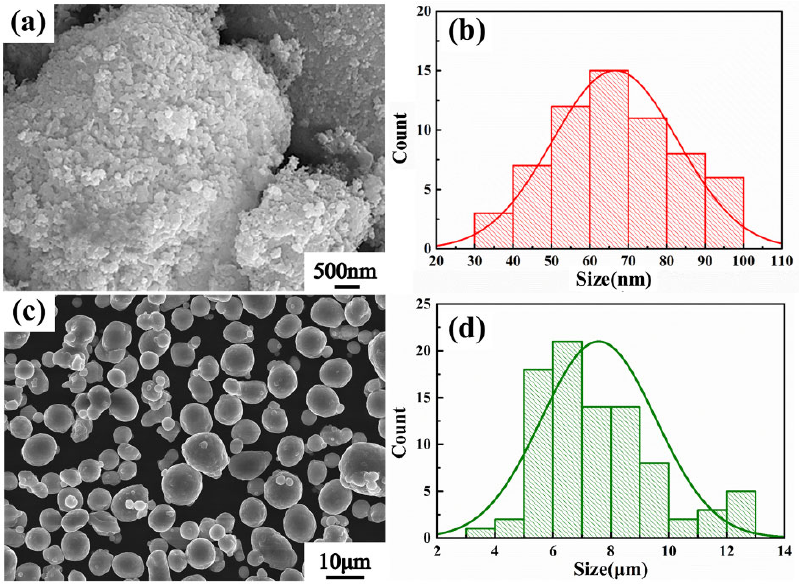
Table 1. Chemical compositions of AA6061 powder.